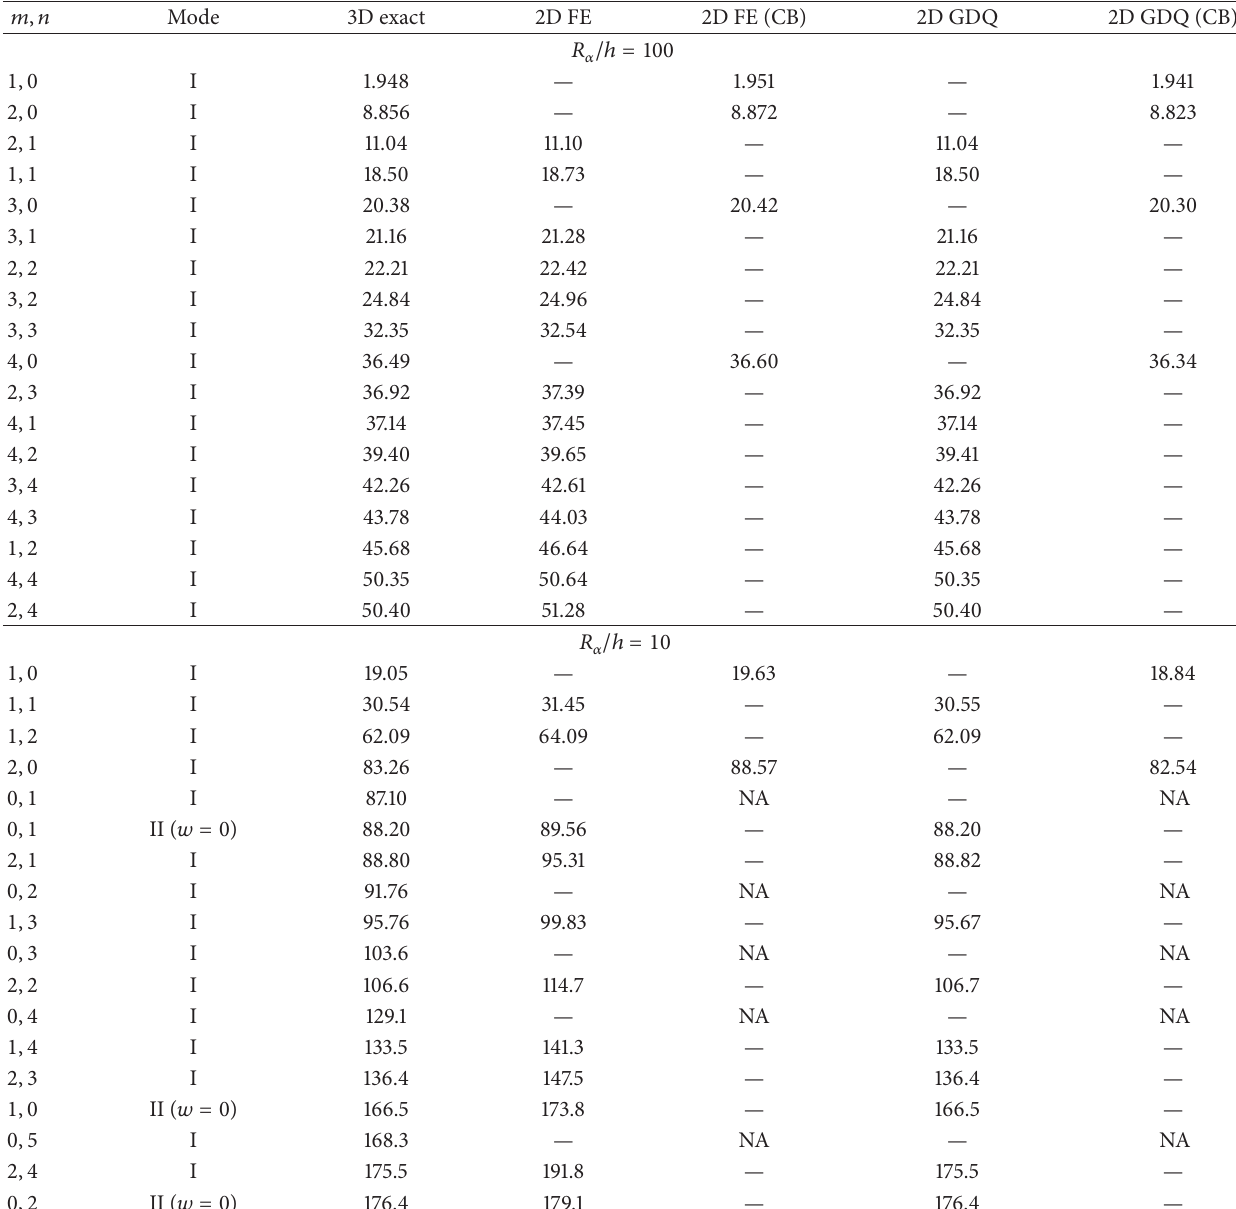
Table 4: Sandwich cylindrical shell panel embedding FGM core with 𝑝 = 1.0 . Analytical 3D versus 2D numerical models. Frequency 𝑓 in